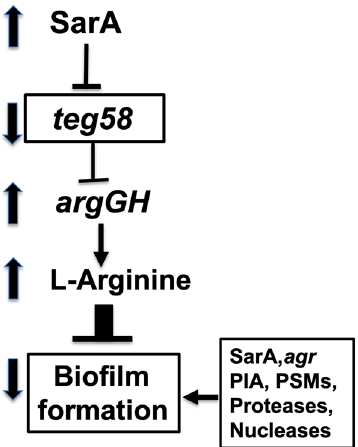
Figure 9. Proposed teg58 -mediated pathway in biofilm formation via arginine production in S. aureus . SarA repressed teg58 , a sRNA that represses argGH for l-arginine synthesis and production. teg58 mediates biofilm formation independent of SarA, agr, ica (PIA), psms (PSMs), proteases ( aur, sspA, sspB, splA-F ) and nucleases ( nuc and nuc2